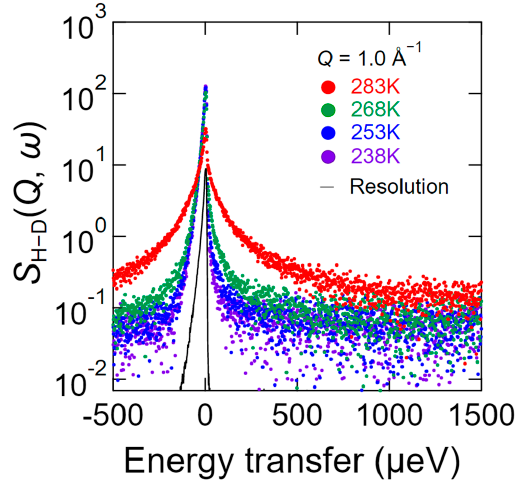
Figure 4. QENS profiles of S H − D ( Q , ω ) at Q = 1.0 Å − 1 in the energy range of − 500 to 1500 µeV with a resolution of 12 µeV at 238 K (purple), 253 K (blue), 268 K (green), and 283 K (red). S H − D ( Q , ω ) is the scattering intensity that represents the water dynamics of the hydrated chitosan, and is obtained by subtracting S D ( Q , ω ) from S H ( Q , ω ), where S H ( Q , ω ) is the scattering intensity of the chitosan hydrated with H 2 O and S D ( Q , ω ) is that of the chitosan hydrated with D 2 O. The black curve represents the resolution profile of vanadium obtained by QENS.